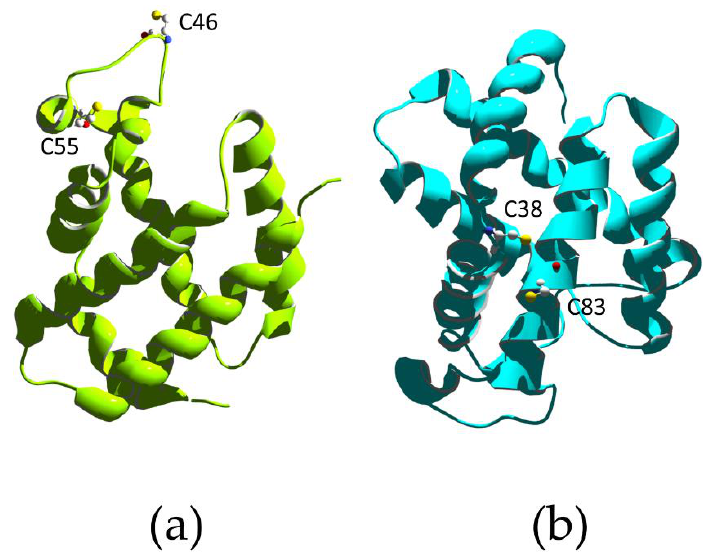
Figure 3. X-ray structure of human neuroglobin ( a ) (PDB ID 1OJ6 [106]) and human cytoglobin ( b ) (PDB ID 2DC3 [103]). The cysteine residues that regulate the heme Fe reactivity are labeled.